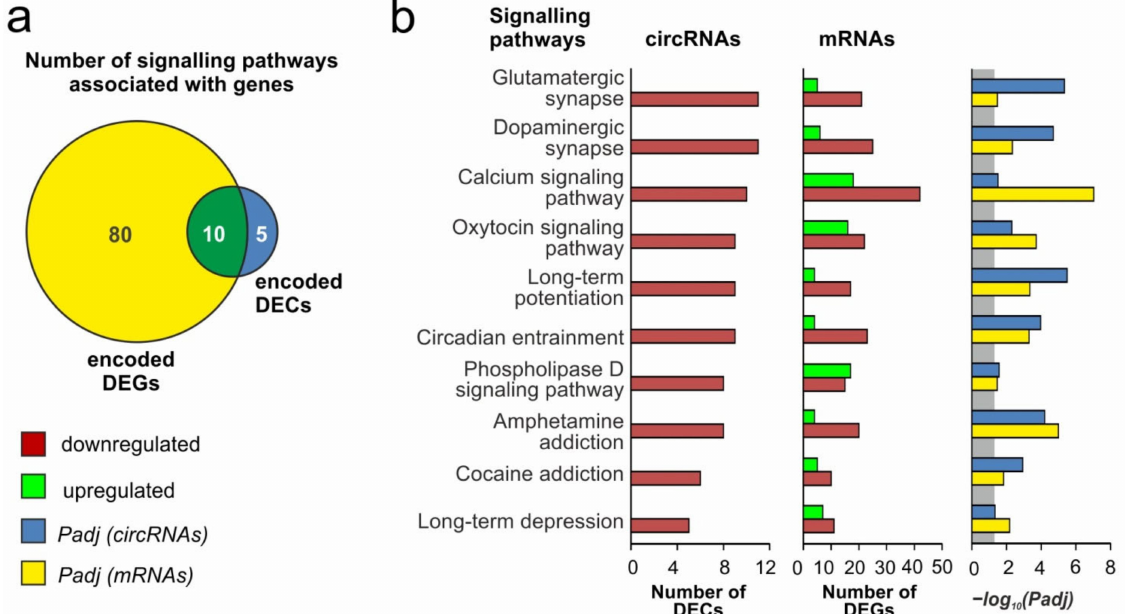
Figure 5. Analysis of the signaling pathways associated with DECs at 24 h after tMCAO. A pathway enrichment analysis of DEGs in pairwise comparisons IR24 vs. SH24 was carried out according to the gProfileR. ( a ) Schematic comparison of the signaling pathways associated with genes that encoded DECs and genes that encoded DEGs obtained in pairwise comparison IR24 vs. SH24 by Venn diagram. The numbers in the diagram segments indicate the number of genes. ( b ) The characteristics of the 10 signaling pathways that lie within the intersection on the Venn diagram ( a ). The number of upregulated and downregulated RNAs, as well as the Padj -values, are shown. Only those RNAs and signaling pathways whose Padj < 0.05 were selected for analysis. Padj ≥ 0.05 are enclosed in the gray